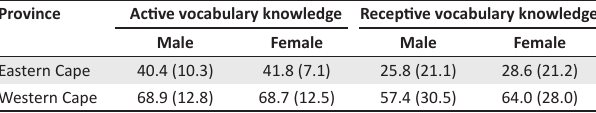
Table 8 reflects gender differences in active and receptive vocabulary knowledge across English HL and English FAL